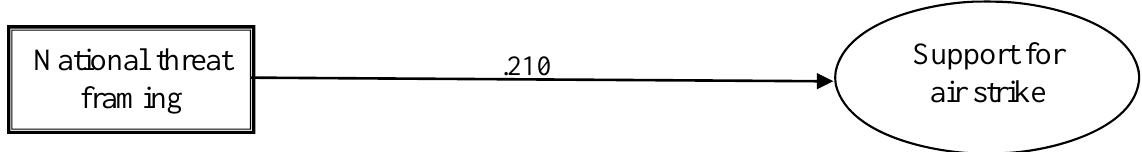
Chi2 (model vs. saturated)=0.5(2), p =.774; RMSEA<.001; CFI=1.000; SRMS=.004 Figure 2: Direct effect of national threat framing on support for an air